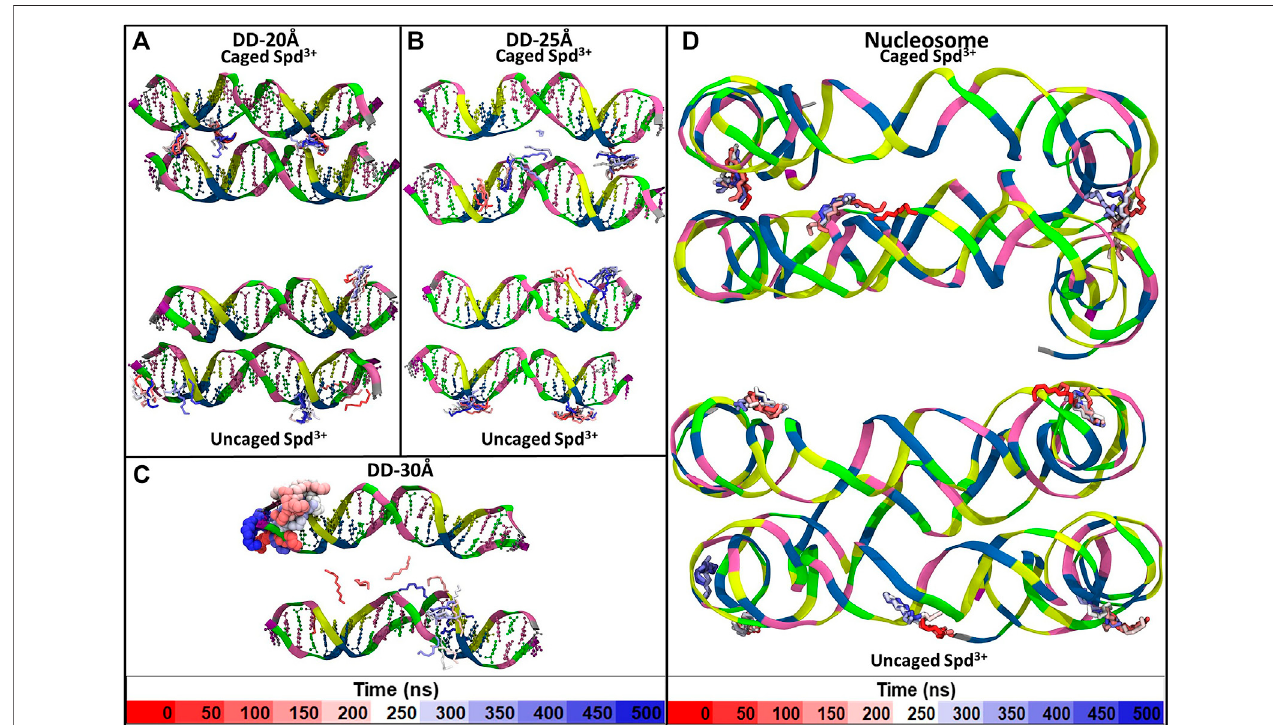
FIGURE 10 | Example of the movement ofindividual Spd 3+ over the duration of the simulation of the (A) DD-20Å system, (B) DD-25Å system, (C) DD-30Å system and (D) Nucleosome system. ForSpd 3+ weused thelicoricerepresentation withHatomsomitted.Each Spd 3+ changescolorfromred towhitetoblue asthesimulation time increases, and each change in color corresponds to 50 ns, as shown by the color-coded time scale in the legend. Larger size representations of the Figures are presented in the Supplementary Figures S2 – S5 .